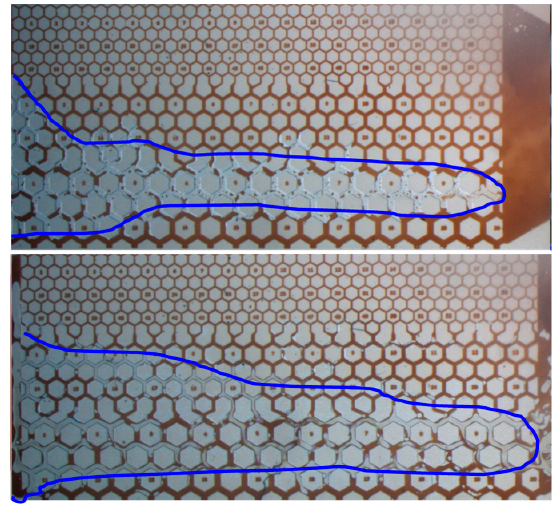
Figure 6. Microscopic oil displacement of waterflooding (upper) and polymer flooding (lower) before water breakthrough.